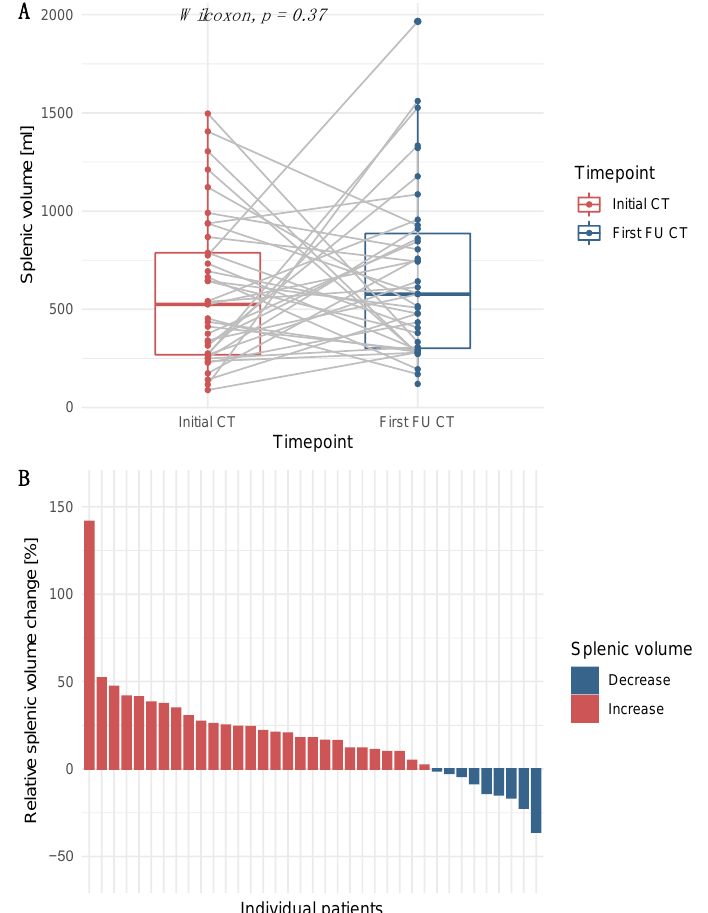
Figure 2. Splenic volume (SV) at baseline and during treatment with immunotherapy agents. ( A ) Boxplots of the SV at baseline and during follow-up. ( B ) Relative individual changes in SV between baseline and first follow-up.